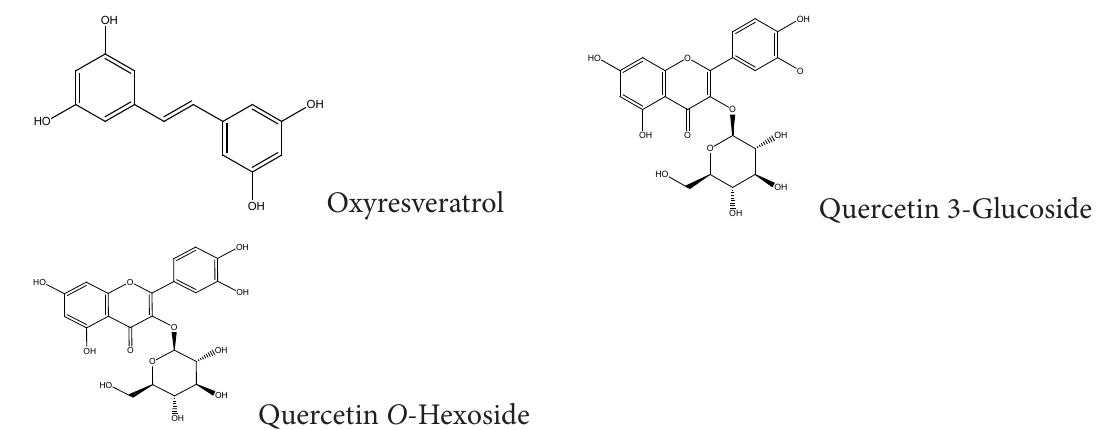
FIGURE 1 - Chemical Structure of Quercetin 3-Glucoside, Oxyresveratrol, Quercetin O -Hexoside reported being Leishmania tropica